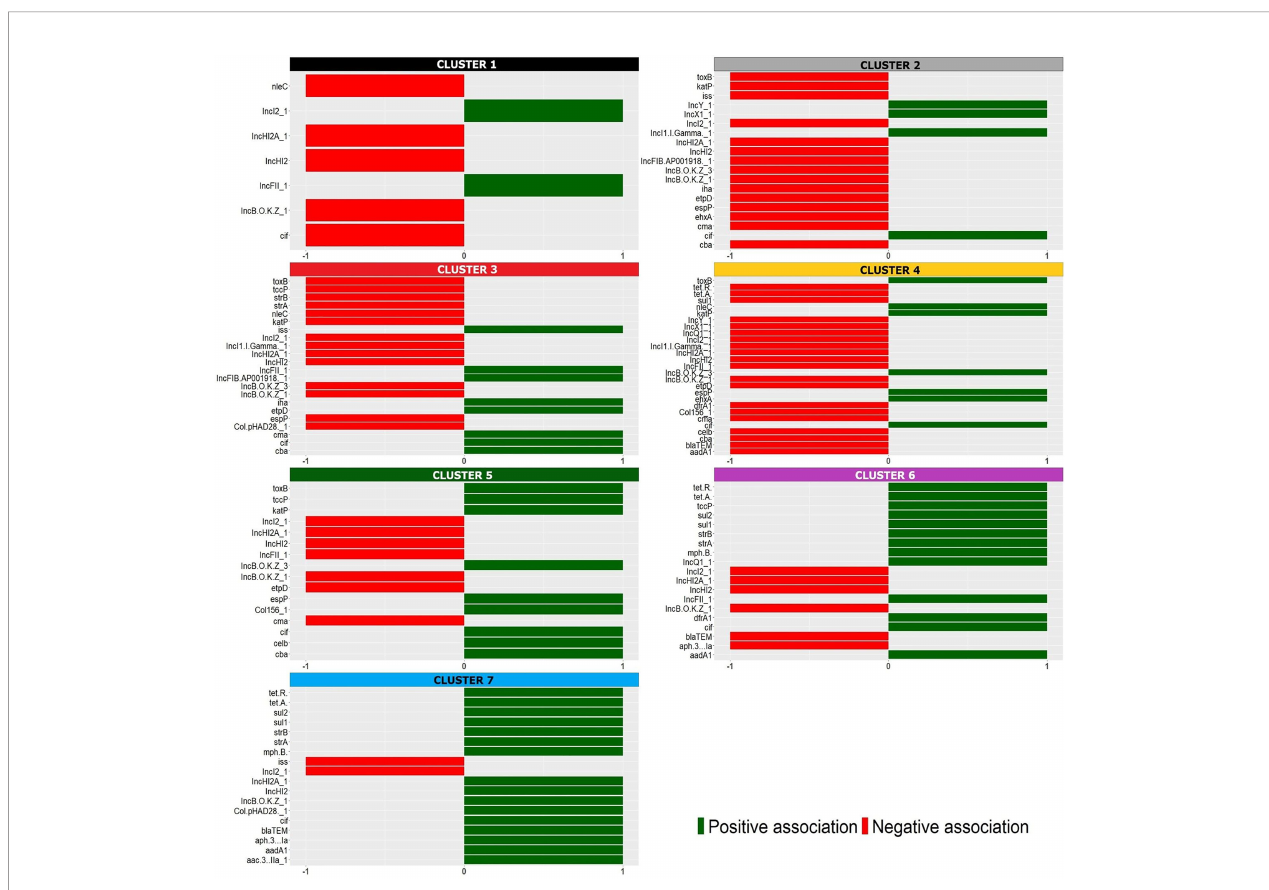
FIGURE 2 | Positive (green) and negative (red) association of the variables with the identi fi ed HCPC clusters, identi fi ed with the colors used in the factor map ( Figure 1